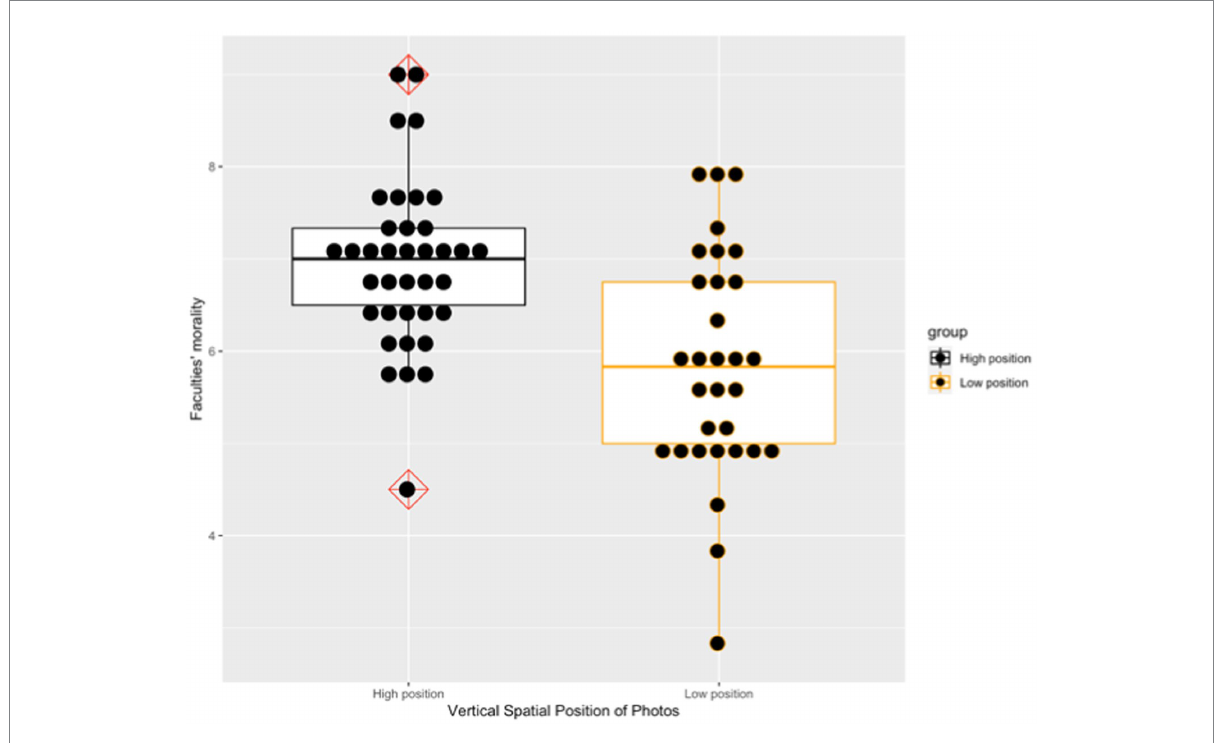
FIGURE 3 Two groups’ rating about the faculty members’ morality in Study